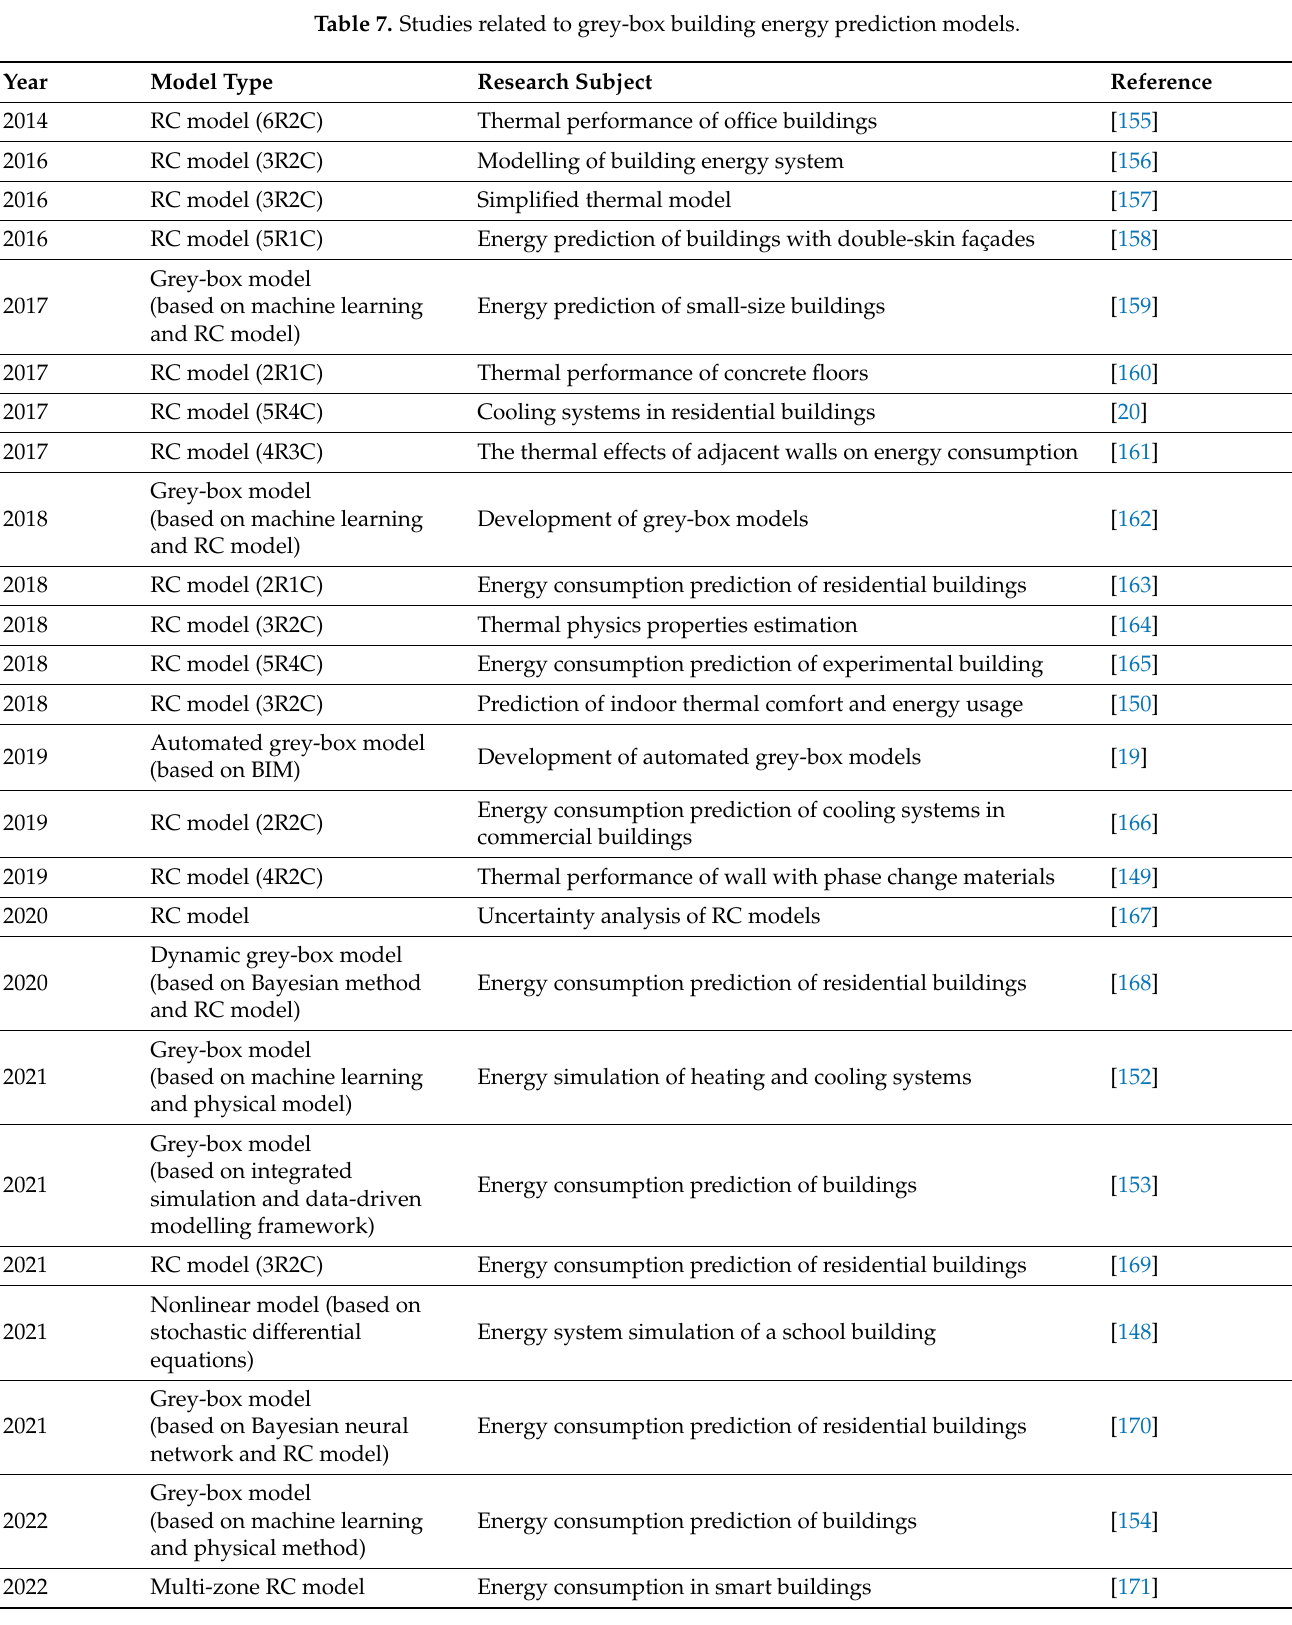
Table 7. Studies related to grey-box building energy prediction